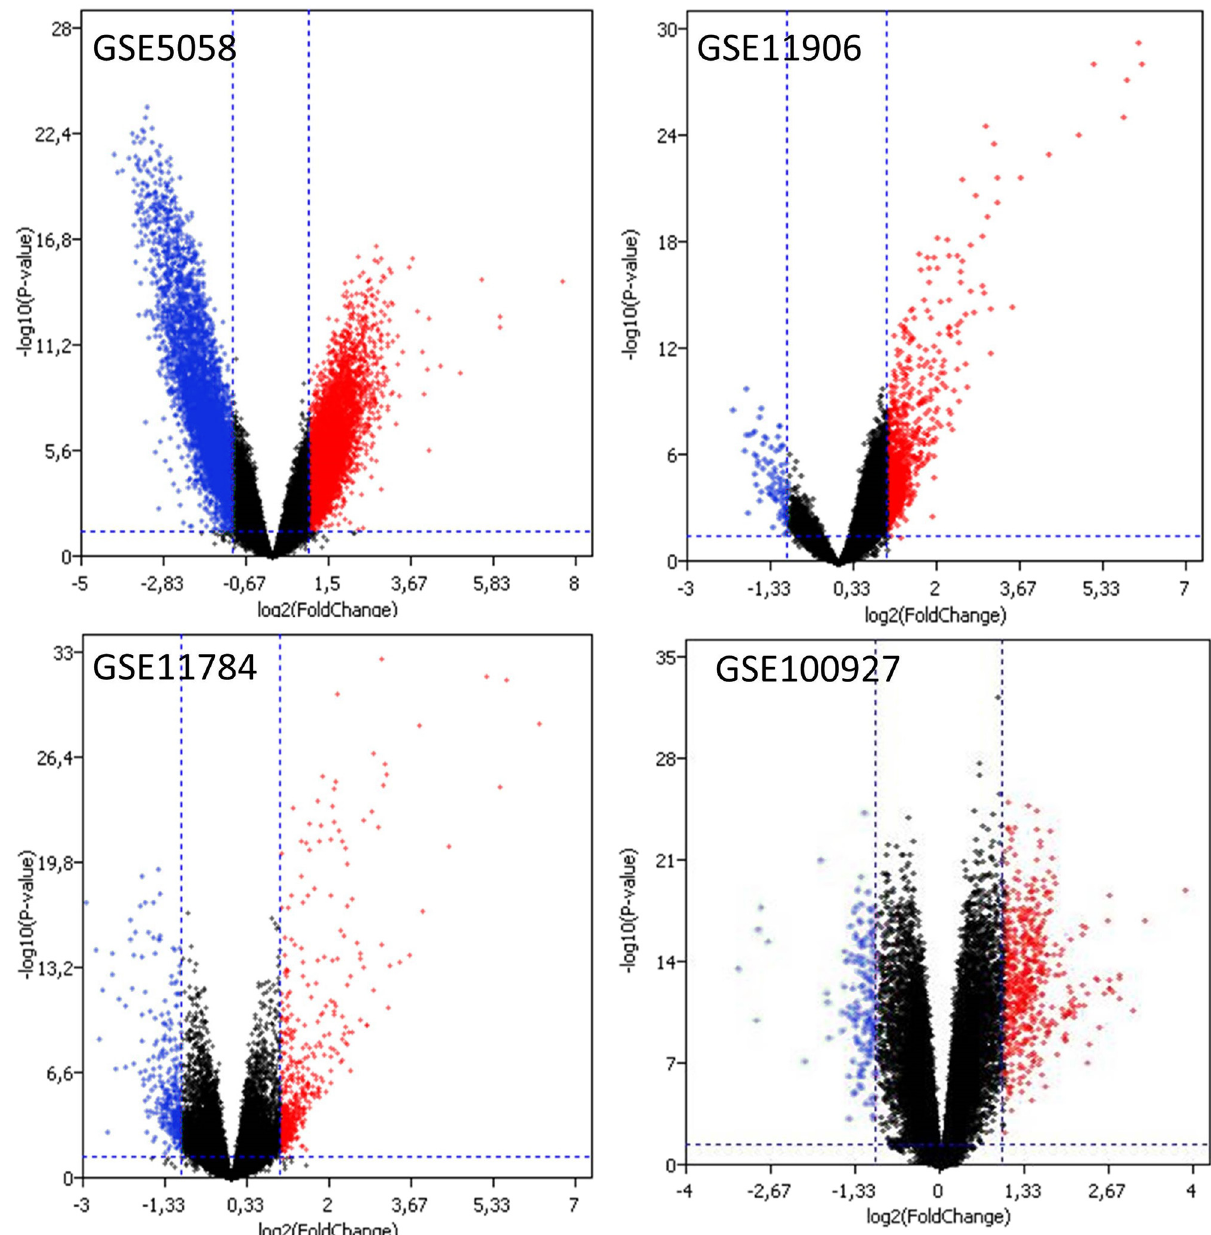
Figure 1: Volcano plots characterizing DEGs in selected sets. Colored dots in the graph indicate genes showing di ff erential expression with | log 2FC | > 1 and p < 0.05, while black dots do not meet these criteria. The red dots indicate upregulated DEGs and are displayed on the right side of the graph, and the blue dots indicate downregulated DEGs – they are displayed on the opposite